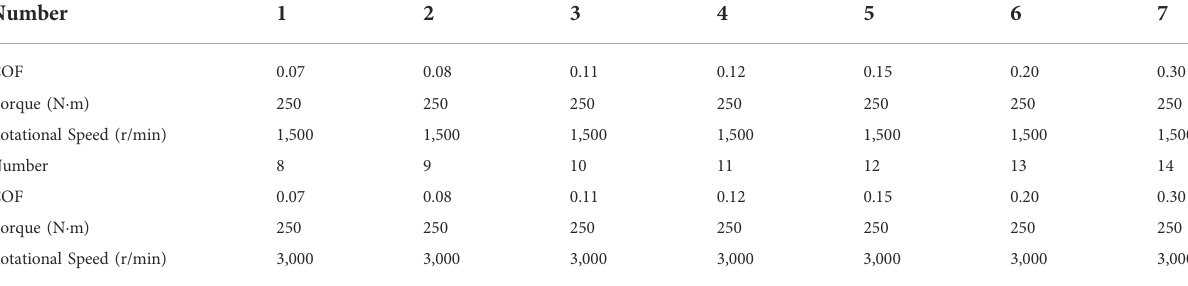
TABLE 3 Simulation parameters.